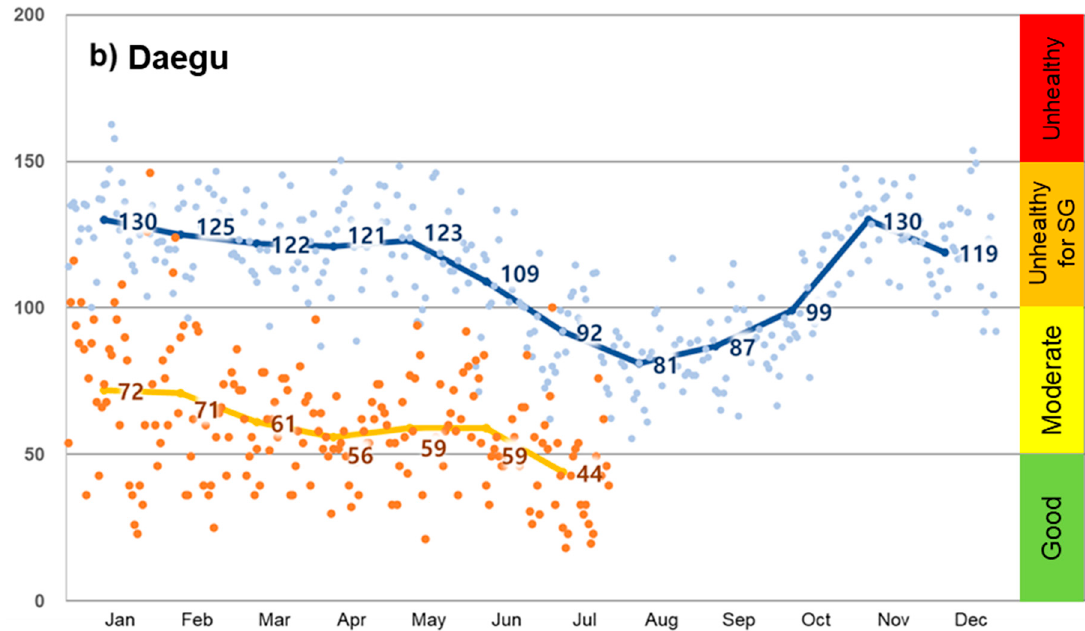
Figure 7. Comparison of daily and monthly air quality index (AQI) between 2020 and the previous three years ( a : Seoul, b : Daegu). Categories of the AQI are “good” (green, 0–50), “moderate” (yellow, 51–100), “unhealthy for sensitive groups (SG)” (orange, 101–150), and “unhealthy” (red, 151–200). “Very unhealthy” (purple, 201-300) and “hazardous” (maroon, 301–500) were not observed in this study.